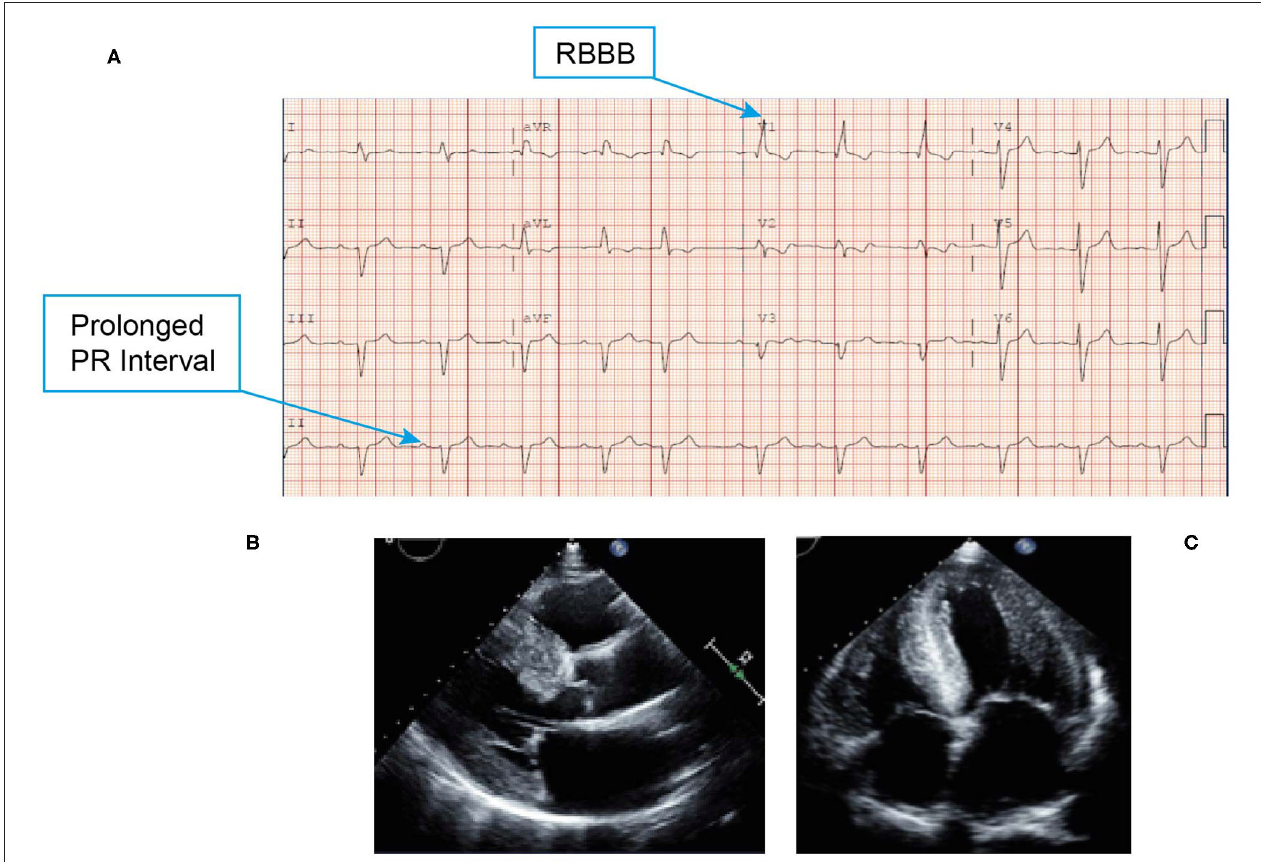
FIGURE 8 | ECG (A) showing low voltage QRS, first-degree atrioventricular block and conduction system abnormality with PR interval prolongation with RBBB. Echocardiogram (B,C) revealing marked thickening of the left ventricle, right ventricle, and biatrial enlargement, and a classic speckled appearance. ECG, electrocardiogram; QRS, Q wave, R wave, and S wave; RBBB, right bundle branch